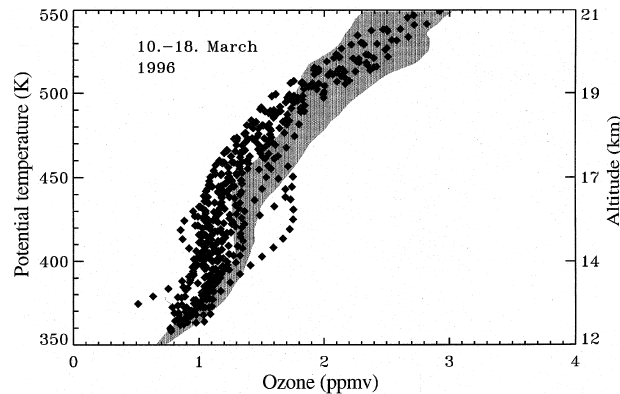
Fig. 16. As Fig. 15, but HALOE ozone profiles in March 1996 in the vortex ( diamonds ) compared with lidar observations ( Donovan et al ., 1996) between March 10 and March